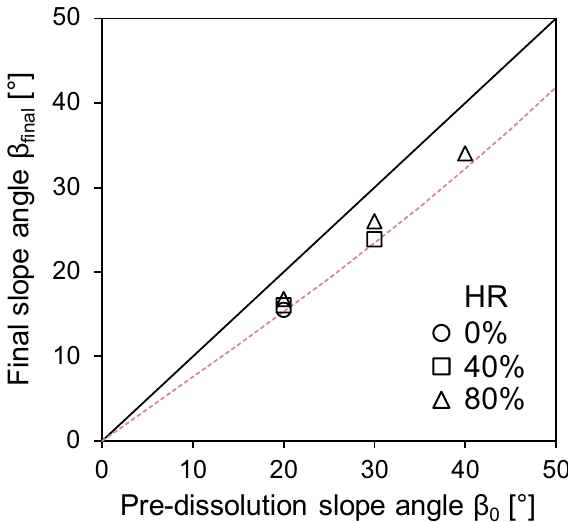
Figure 12. Comparison of the initial slope angle, β o , and the final slope angle after dissolution, β final , for all cases (SF = 25%). The dotted line is an upper bound estimate ΔH/H o = SF when dissolution takes place at constant